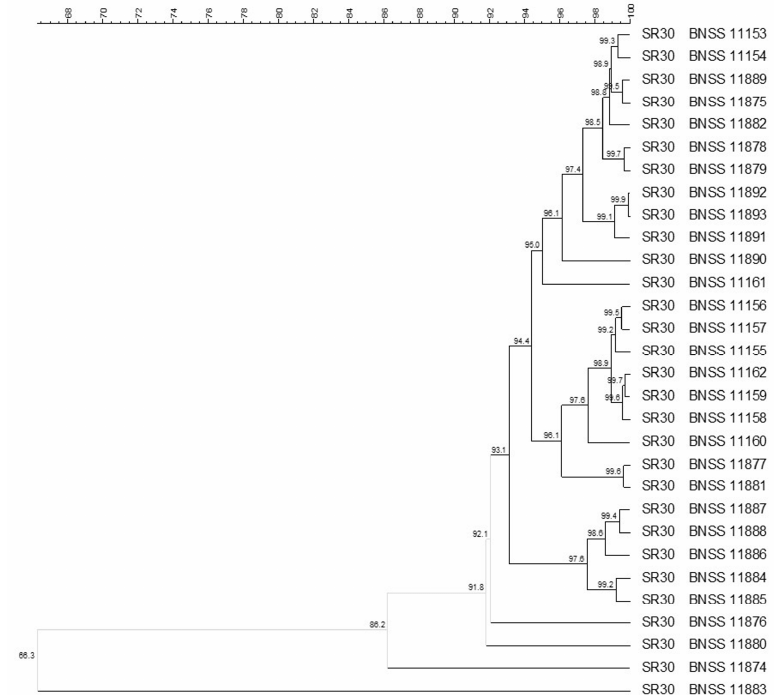
Figure 2. UPGMA cluster analysis, using Pearson correlation, of (GTG) 5 rep-PCR and PFGE elaborated by composite data set comparison tool, of 30 Streptococcus thermophilus isolates from SR30 natural culture. For each isolate, the indication of the culture and the BNSS ID were reported.